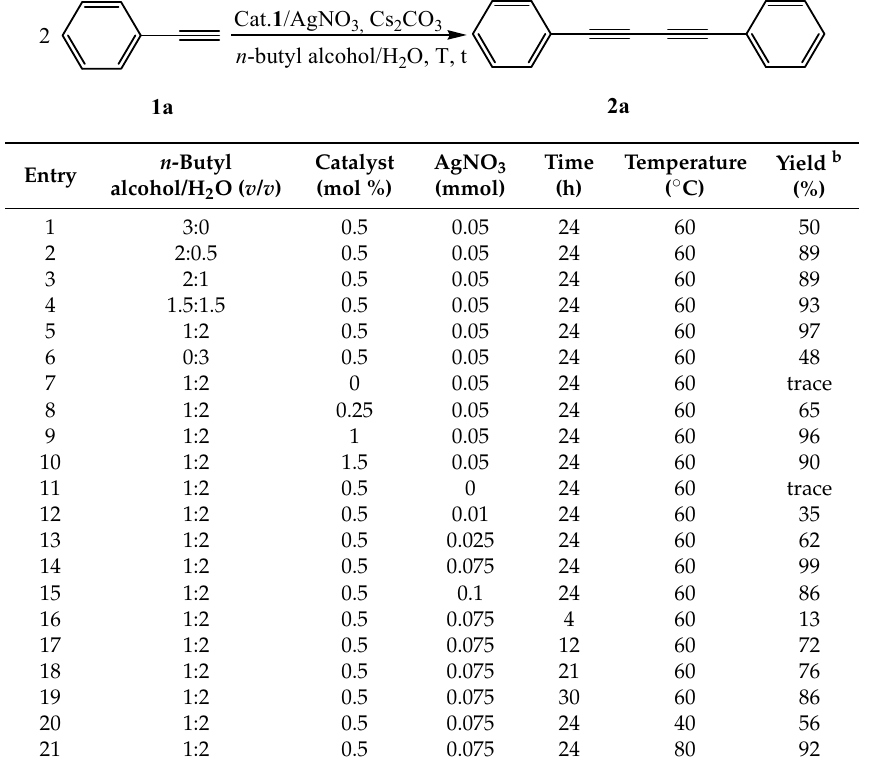
Table 2. Effects of other reaction conditions on the homocoupling of phenylacetylene a .